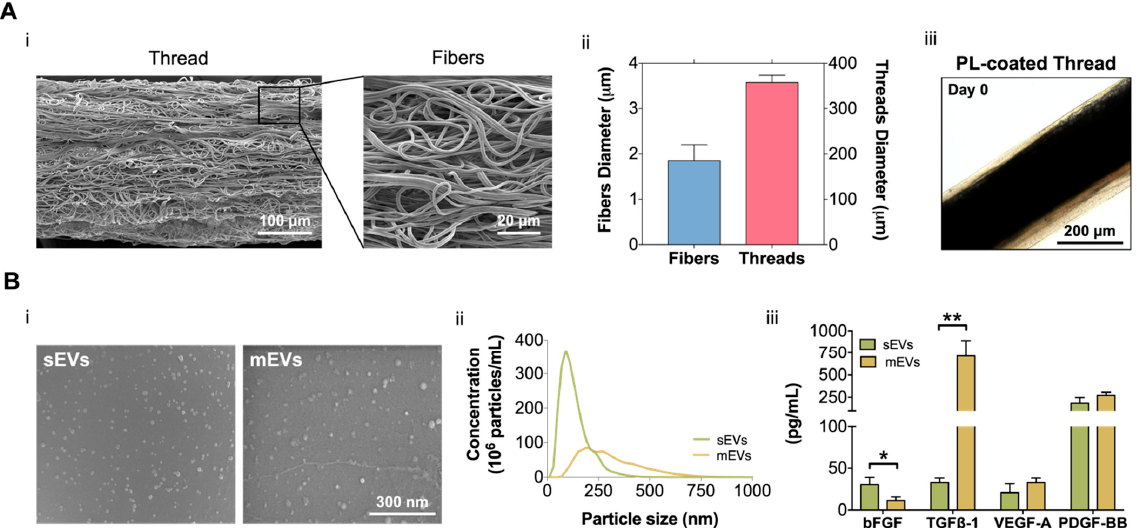
Figure 1. ( A ) (i) Scanning electron microscopy (SEM) micrographs of the produced misaligned fiber threads. Scale bars: 100 µm and 20 µm. (ii) Isotropic fibers and threads diameter. Data are presented